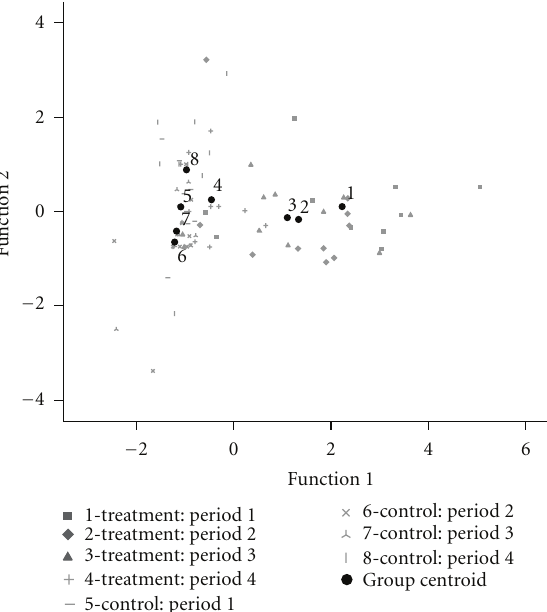
Figure 3: Plants of the treatment group presented higher mean ant richness than control group in all periods (Repeated measures ANOVA: Group: F (1;118) = 10.47; P < 0 . 01). Di ff erent letters indicate significant di ff erences according to post hoc test (LSD: P < 0 . 05).